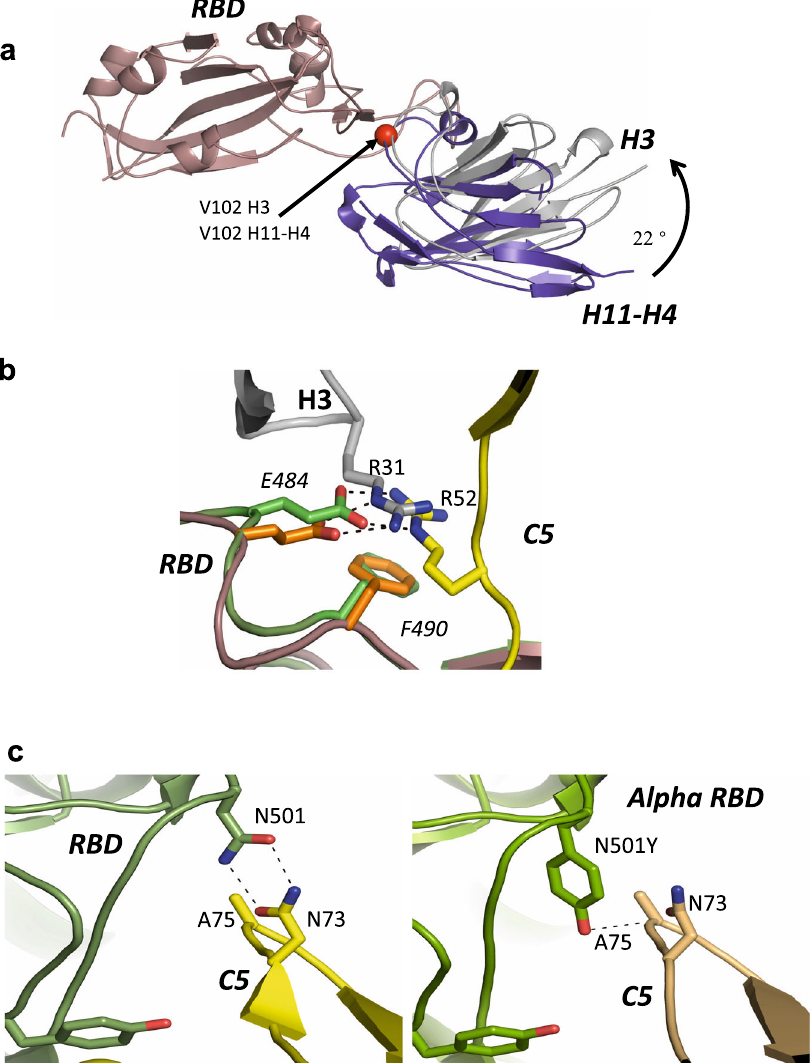
Fig. 3 Comparison of nanobody-RBD complexes. a Superimposition of H11-H4-RBD and H3-RBD complexes; V102 is shown by a red sphere. b Overlay showing the key salt bridge interaction between E484 in RBD and R31 in nanobody H3 and R52 in nanobody C5, respectively. c Close-up of the RBD-C5 interfaces for complexes with the Victoria strain of SARS-CoV-2 (N501: left hand side) and Alpha strain (N501Y: right hand side) showing the hydrogen bonding between N501 and Y501 of RBD (coloured green) with N73 of C5 in yellow and wheat respectively. Key residues are shown in stick